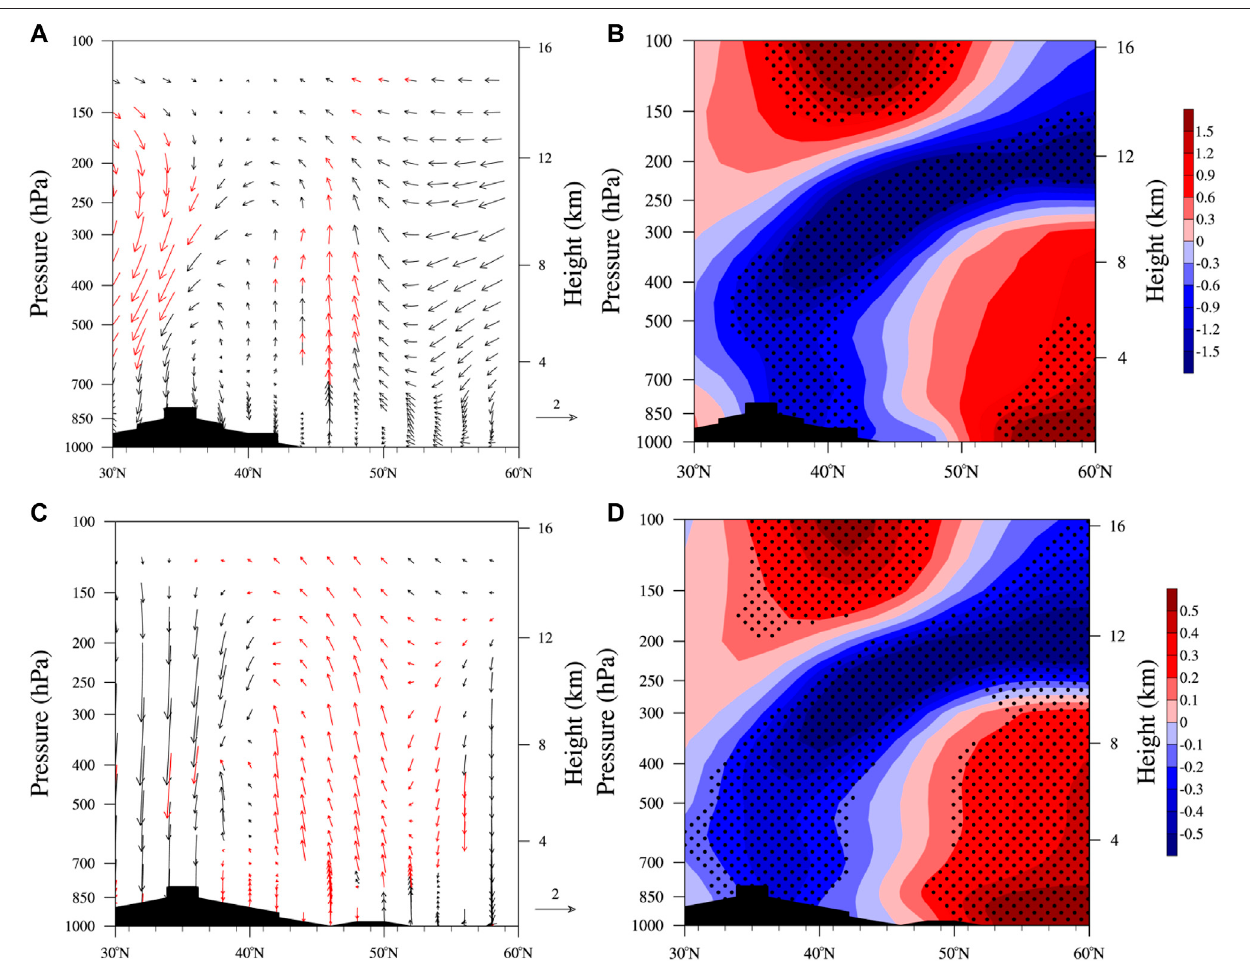
FIGURE 7 | (A,B) shows the difference in the zonal pro fi le after the radial average of the wind fi eld and temperature between the maximum and minimum TP monsoon index years, respectively. (C,D) depict the regression coef fi cient distributions of the TP monsoon index for a zonal pro fi le after the radial average of the wind fi eld and temperature, respectively. The red wind fi eld in (A,C) and the dotted area in (B,D) show the area that passed the 90% con fi dence level student ’ s t-test.